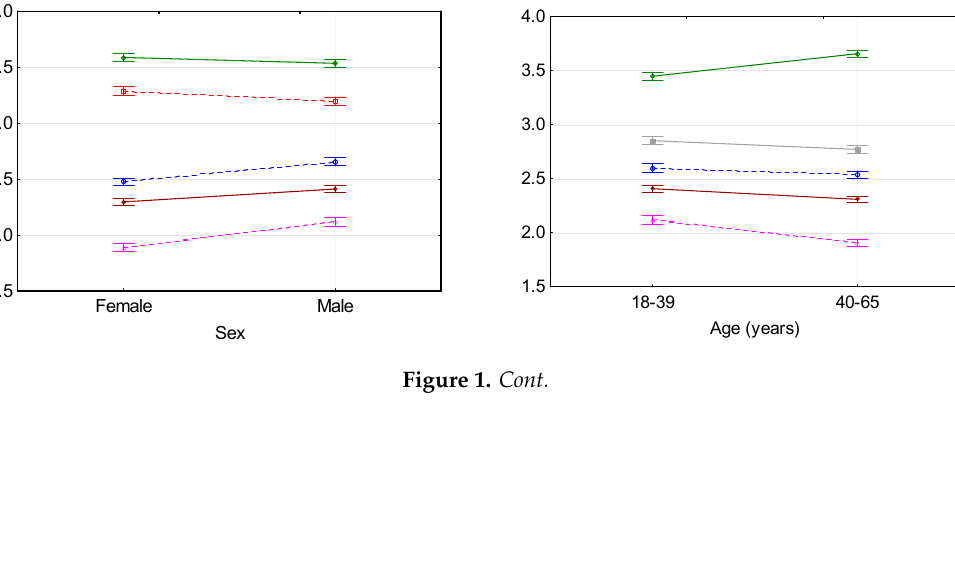
Table 4. Significance of predictors in multi-way ANOVA main effects only model (F